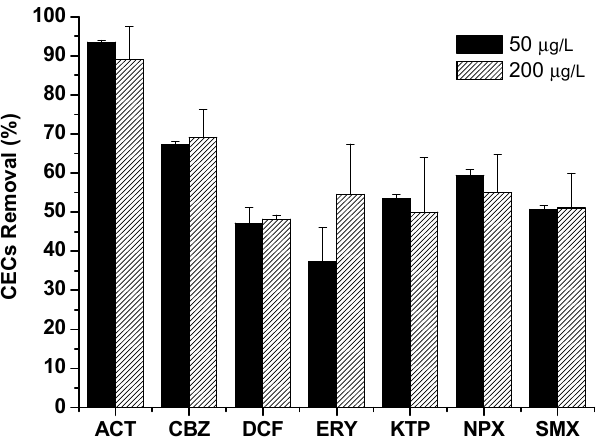
Figure 6. CECs removal percentages at two inlet concentrations (200 and 50 µ g / L).